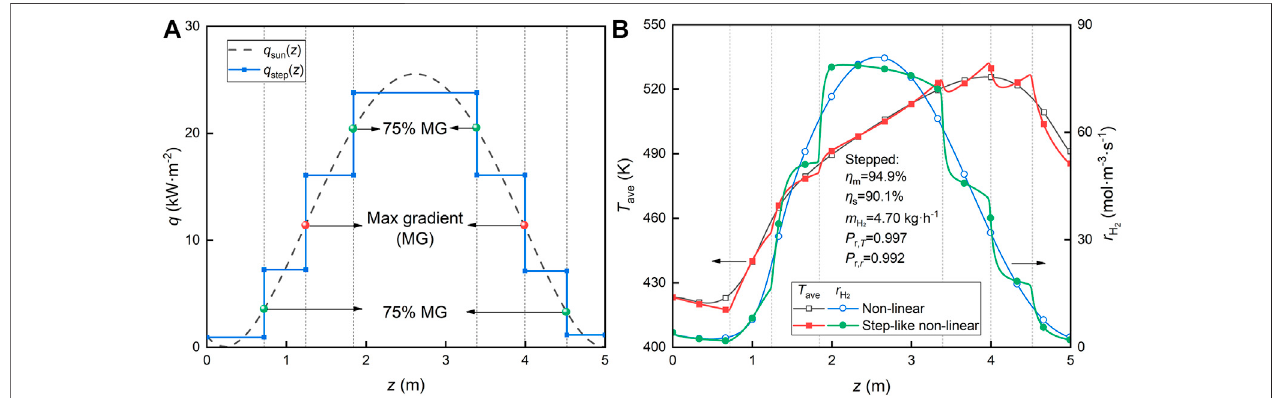
FIGURE 9 | Step-like fl ux regression results for non-linear fl ux distribution. (A) Non-linear fl ux distribution regression and (B) fi eld variable distribution.